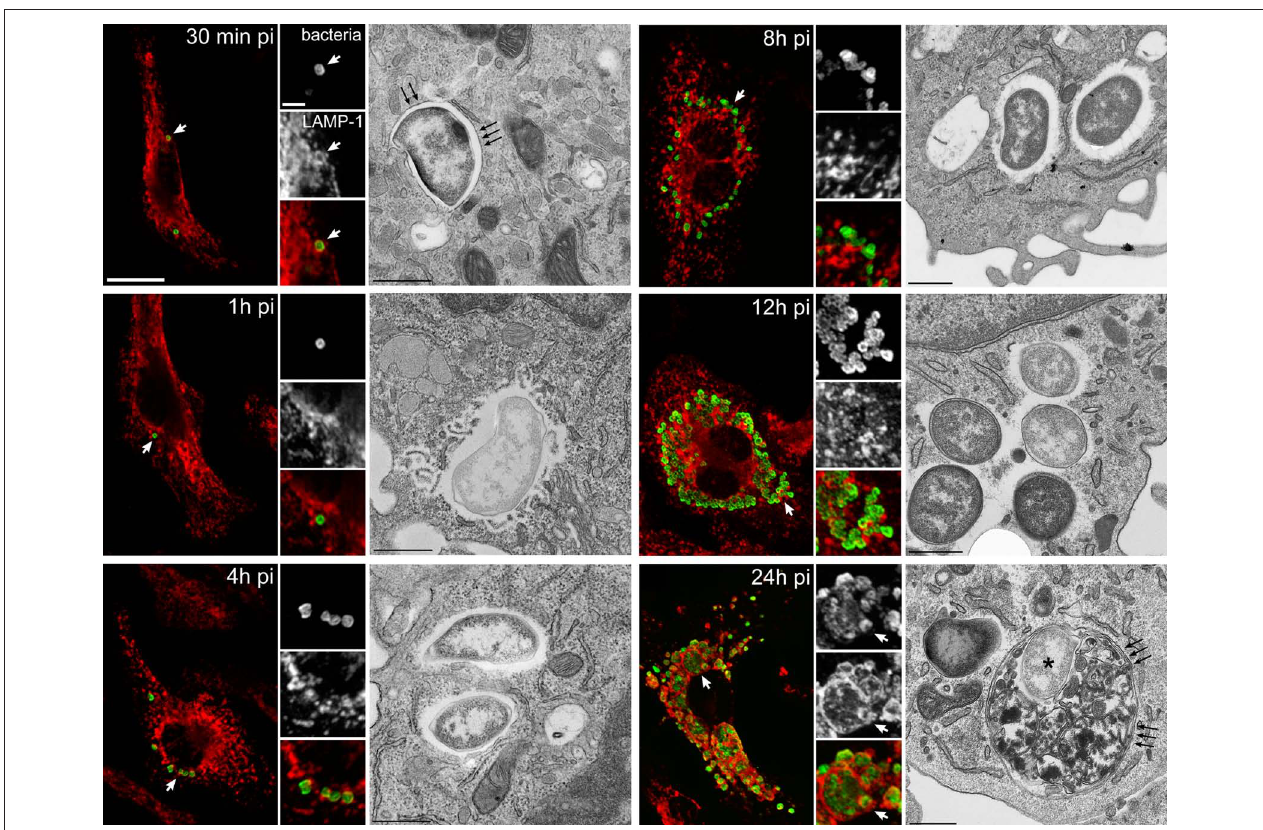
formation. Bacteria appear in green and endosomal, LAMP-1-positive membranes appear in red. White arrowheads indicate either regions of interest in whole images or bacteria enclosed within a LAMP-1-positive compartment in insets. Black arrows in TEM micrographs indicate single or double membranes surrounding intracellular bacteria. Scale bars, 10 and 2 μm (confocal images) or 0.5 μm (TEM images). Reproduced with permission from John Wiley and Sons